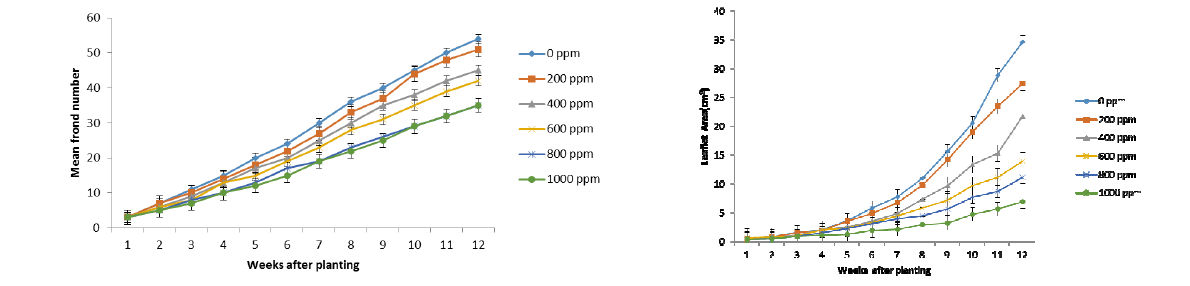
Fig. 6. Effect of different treatments of lead on the leaflet area of Pityrogramma calomelanos